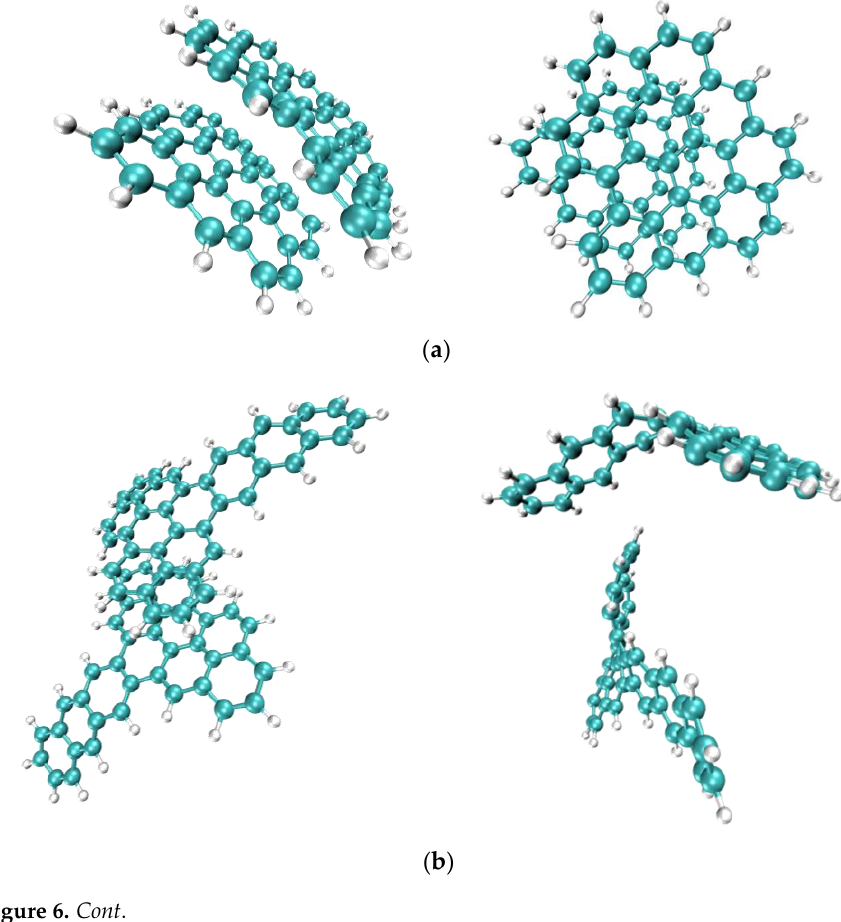
Figure 5. The aggregation behavior of asphaltene molecular dimers [18]. ( a ) Face – face geometry, ( b ) T-shaped or edge-on geometry, and ( c ) offset π -stacked geometry.